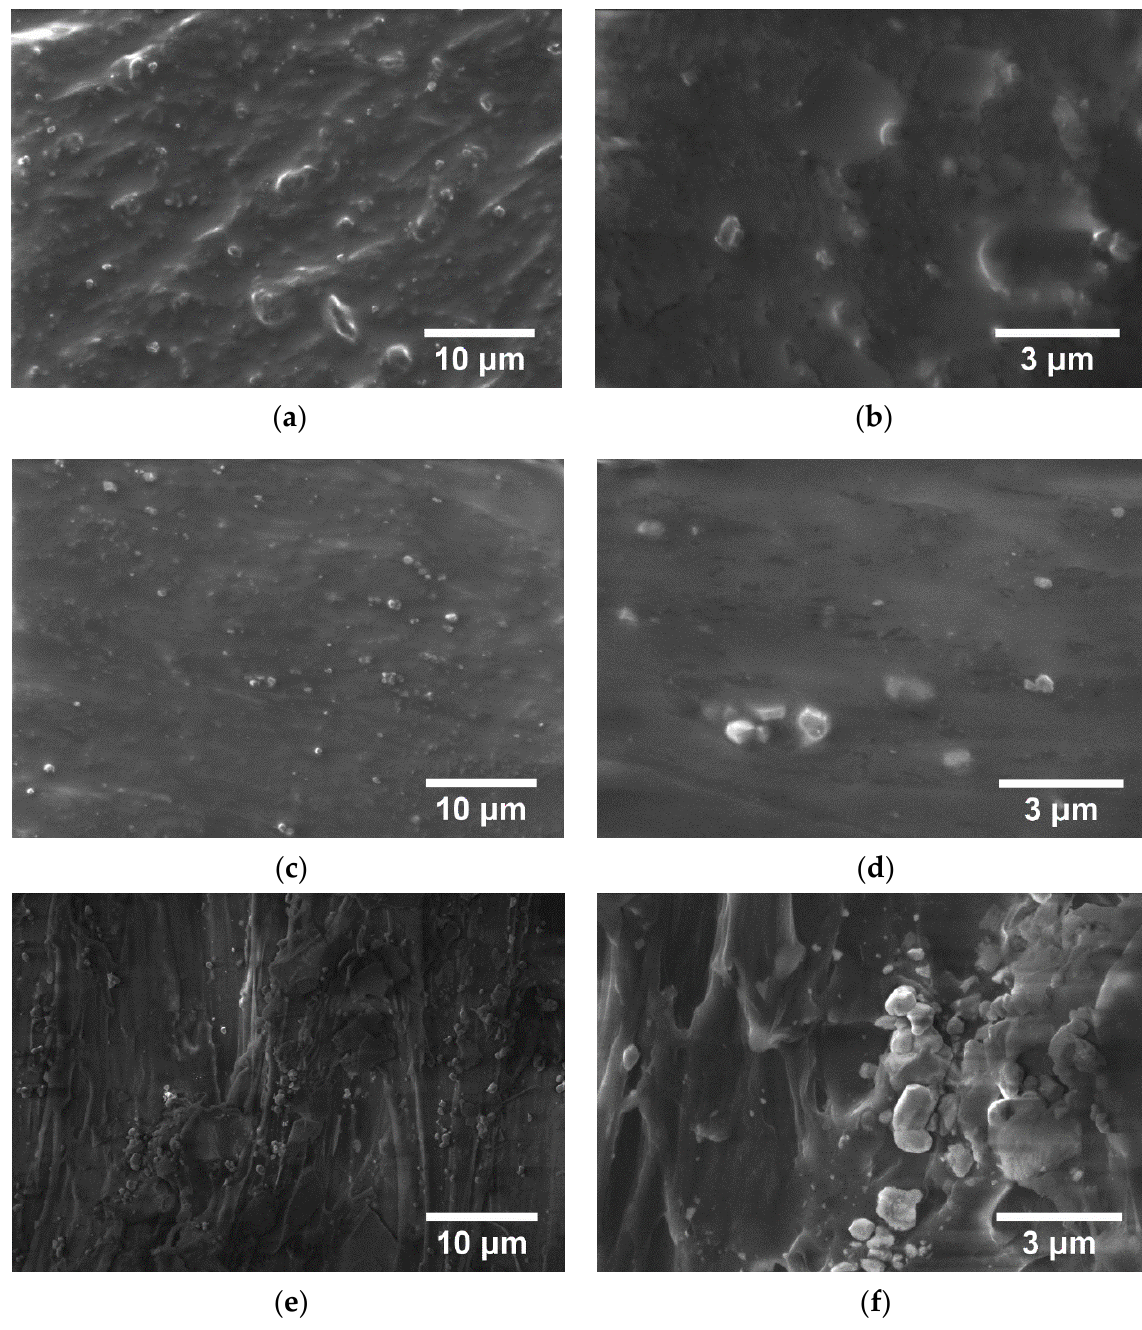
Figure 15. SEM images for composite material M1 at magnifications 5.000 × ( a ), 20.000 × ( b ), M2 at magnifications 5.000 × ( c ), 20.000 × ( d ), M3 at magnifications 5.000 × ( e ), 20.000 × ( f